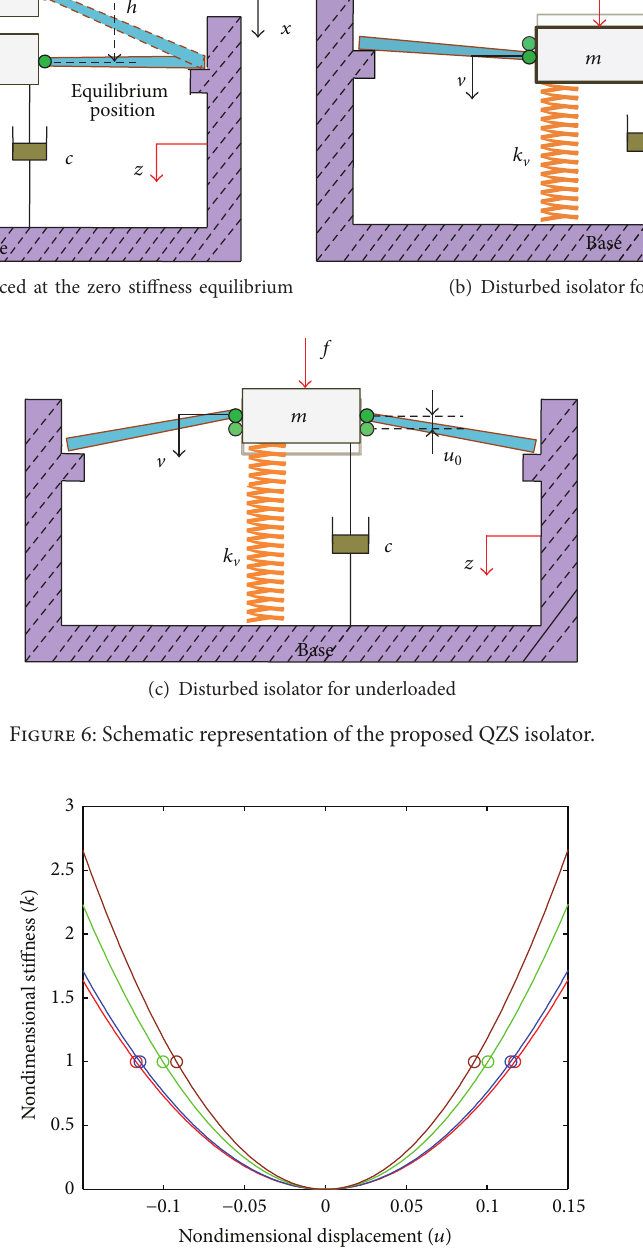
Figure 7: Nondimensional stiffness characteristics of the QZS isolator for different configurative parameters. “Red line” curve 1; “blue line” curve 2; “green line” curve 3; “brown line” curve